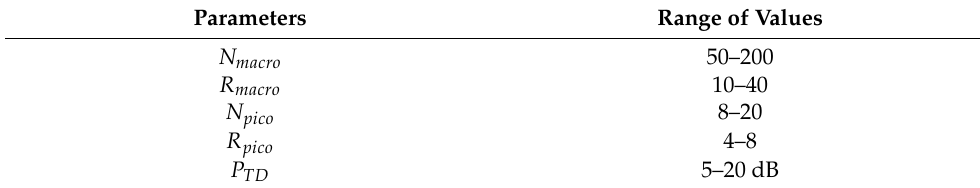
Table 1. Range of values of all input parameters used in the simulation.